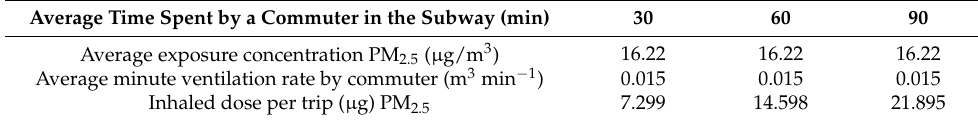
Table 3. Average dose inhaled per trip at different time